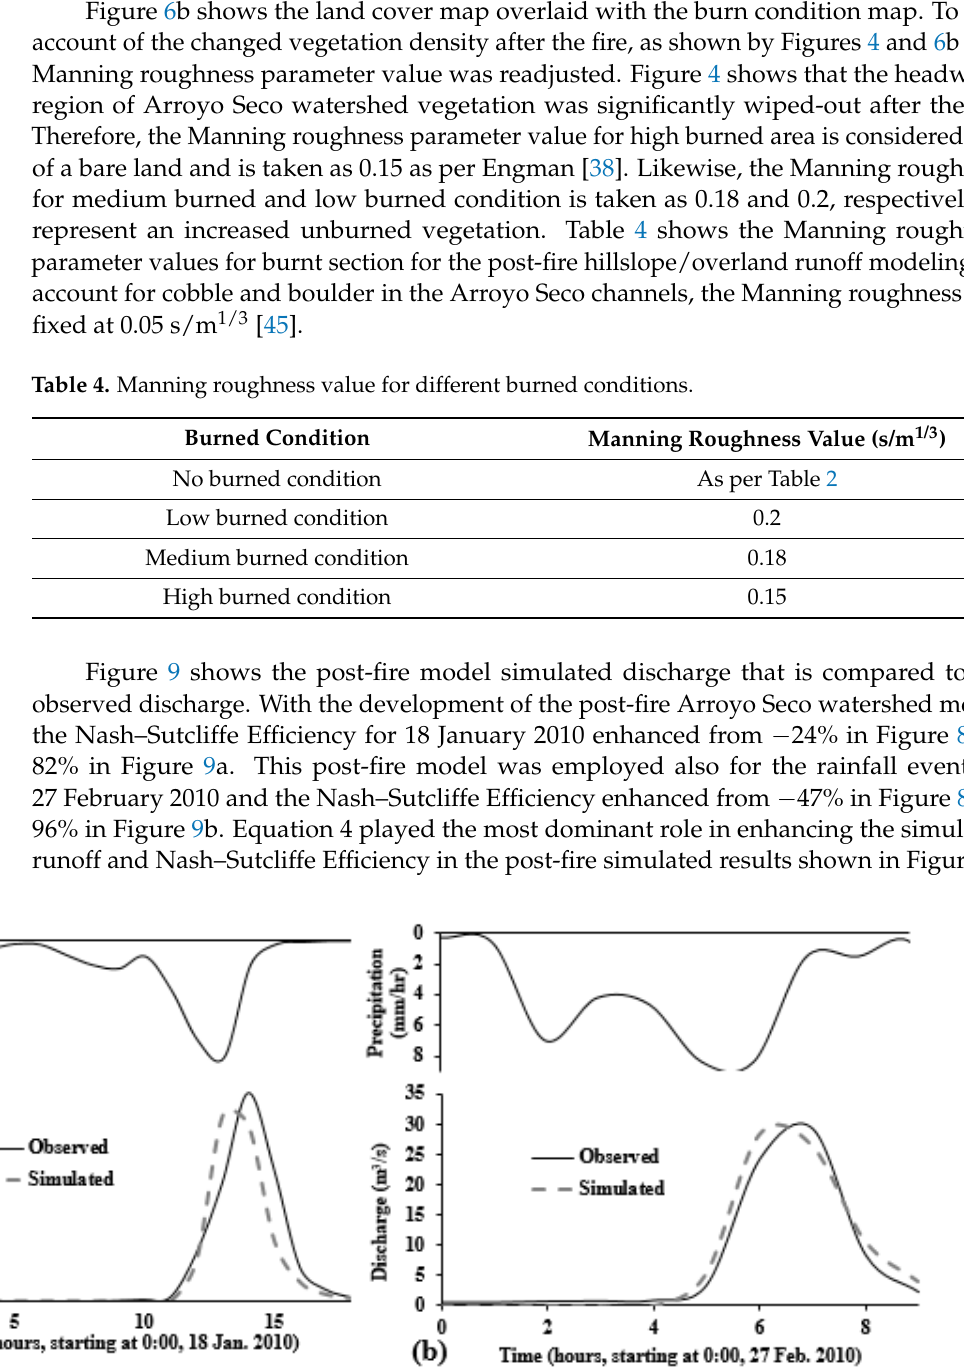
Figure 9. Comparison of simulated runoff with observed runoff, in the post-fire events of ( a ) 18 January 2010 and ( b ) 27 February 2010, after the development of the Upper Arroyo Seco post-fire model.